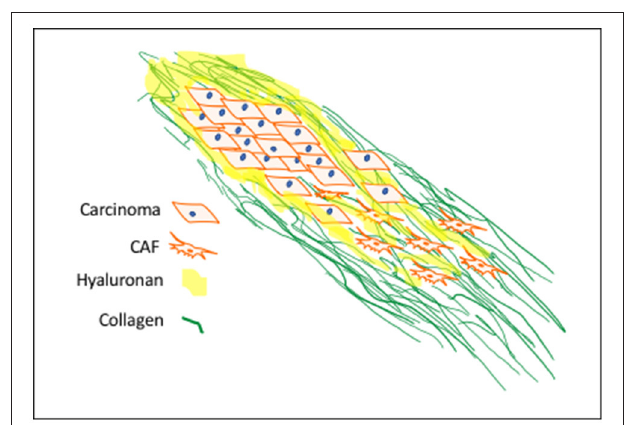
FIGURE 1 | Progression-Associated Fibrosis in Cancerized Stroma: Deregulated synthesis and deposition of ECM components, including HA and type I collagen, leads to tumor-associated fibrosis. HA, a major polysaccharide of provisional wound matrices, contributes to cancer initiation, progression and resistance-to-therapy. CAF activation sustains increased collagen synthesis, structurally oriented by fibroblast contractile forces. These provide structural and biochemical cues to enhance mechano-signaling for carcinoma motility and invasion.